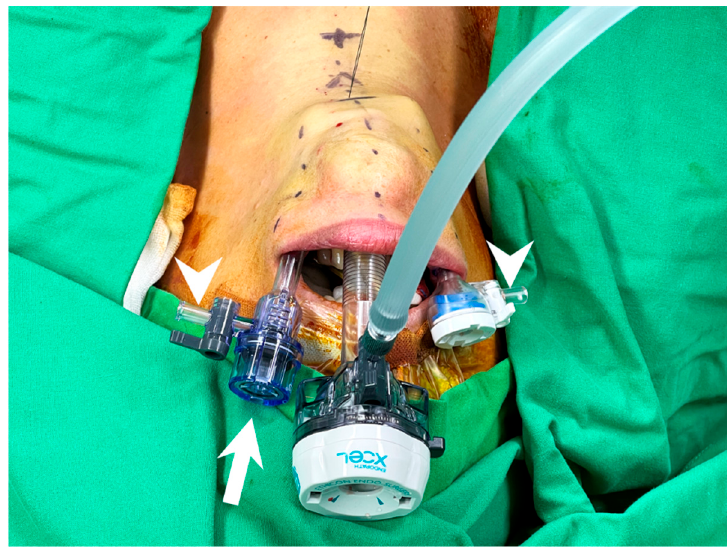
Figure 5. Trocar insertion in transoral thyroidectomy. Trocars with small head are preferred and the left lateral trocar should be inserted a bit deeper to avoid inter-trocar interference (arrow). The venting side port should be turned away from center and faced outside (arrowhead) to eliminate collision.